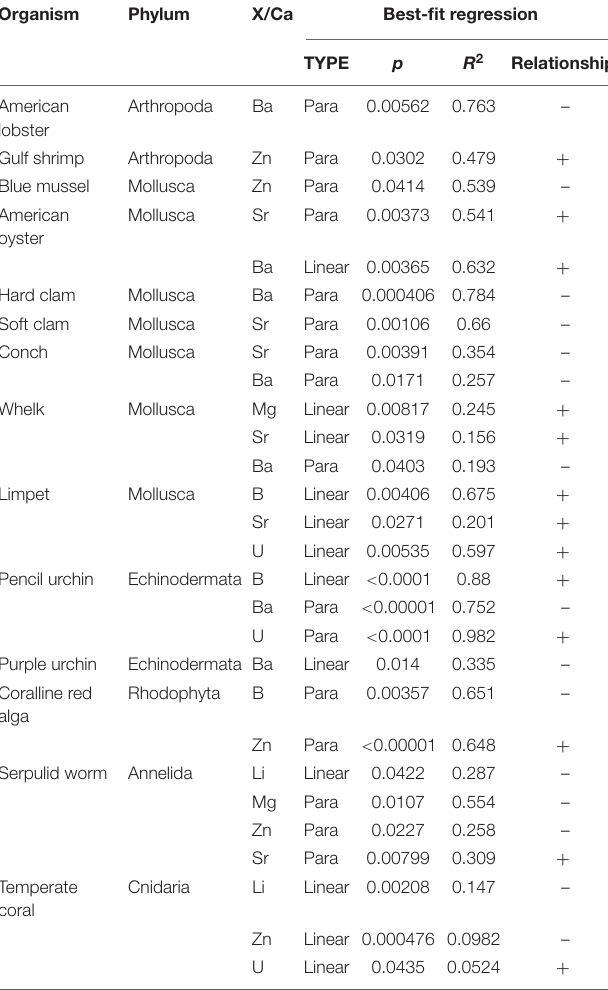
TABLE 3 | Summary of AIC test results for significant relationships ( p < 0.05) between element/Ca ratios and net calcification rates across all organisms. Organism